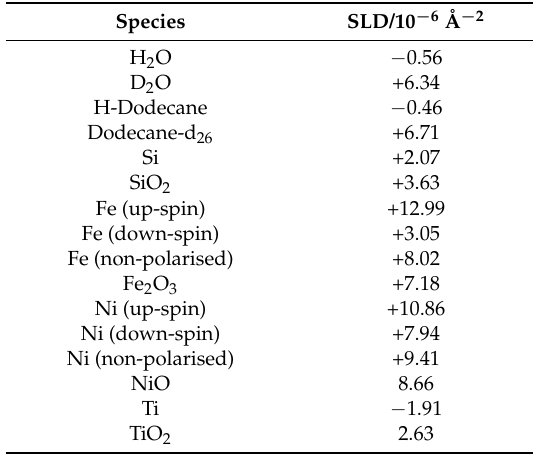
Table 2. Scattering length densities (SLDs) of some representative